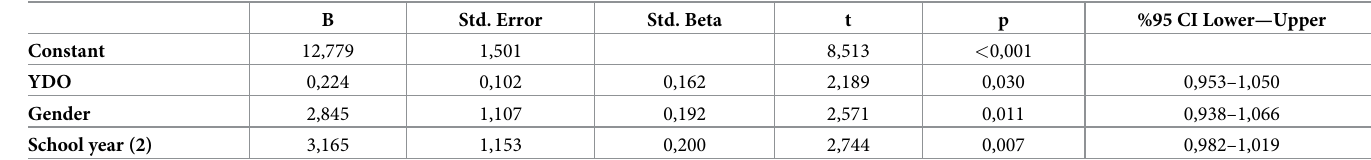
Table 6. Determination of risk factors for the fear of COVID-19 with linear regression analysis used with backward stepwise